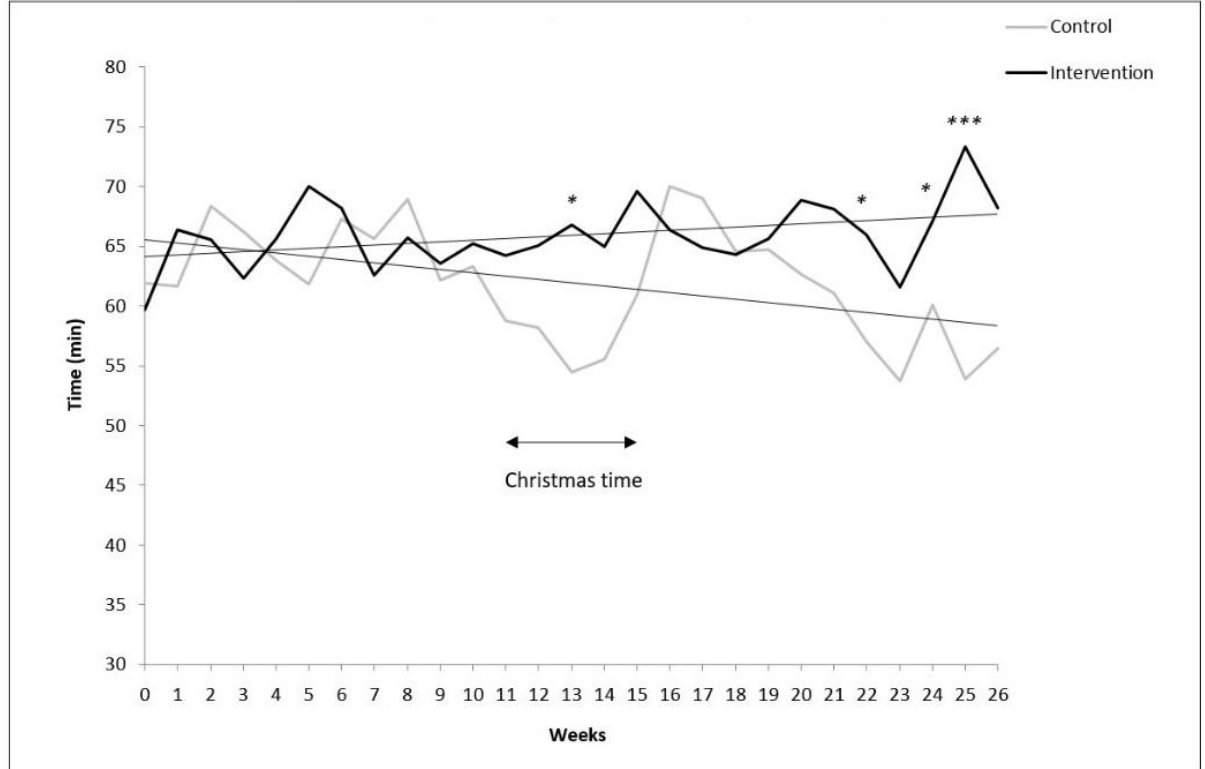
Figure 4. The mean daily time spent in moderate to vigorous physical activity for both study groups as measured by Polar Active during each week of the trial. The average standard deviation was 30.8 min and 24.4 min for the intervention and control groups, respectively. The weeks represent individual weeks from the baseline. Christmas holiday season took place during the study weeks 11 to 15 depending on when the individual started the trial. There was a borderline significant difference between the groups over time ( P =.055, linear mixed model). MET: metabolic equivalent. * P <.05; *** P <.001.* P <0.05; *** P